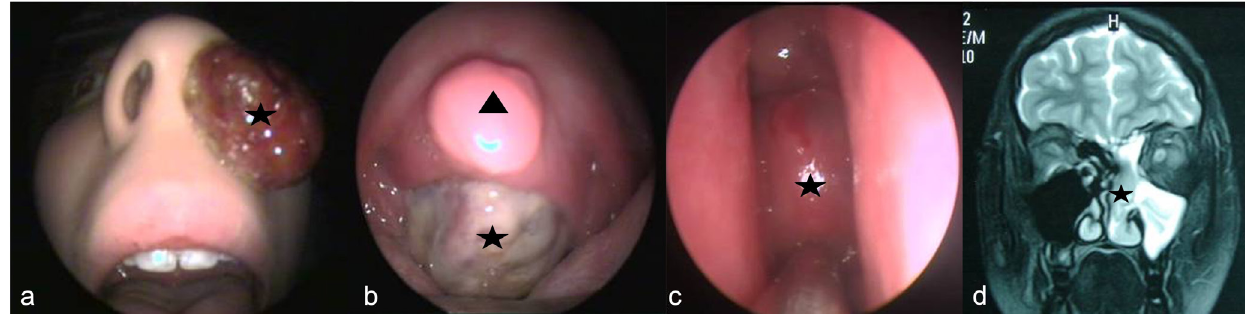
Figure 3. Left sided glomangiopericytoma a) endoscopic view of adolescent patient at presentation b) tumour extending to posterior pharynx endo- scopic view inside oral cavity tumour visible in posterior to uvula c) endoscopic view before last revision surgery left side sinonasal mass covered with mucosa d) preoperative MRI before last surgery coronal view showing tumour attaching to the skull